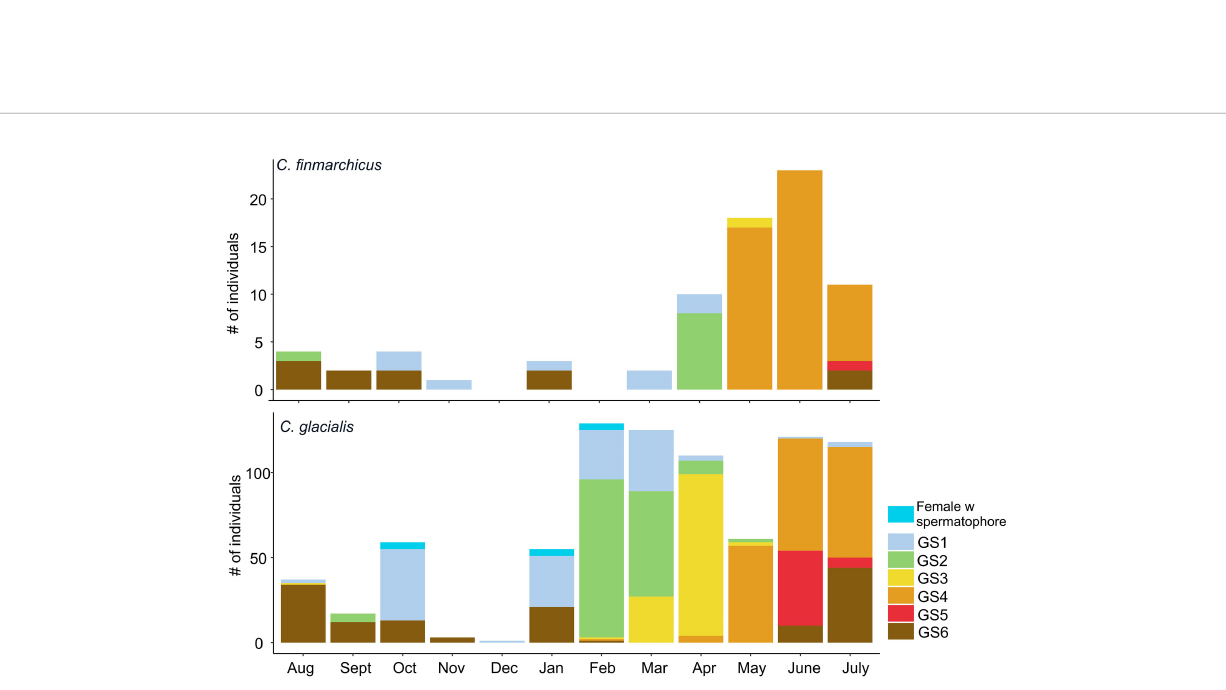
FIGURE 5 | Size structure (prosome length, mm) and maturity stages of Calanus copepodite stage V in Isfjorden from August 2015 to August 2016. The size range of C. fi nmarchicus CV is highlighted in gray.